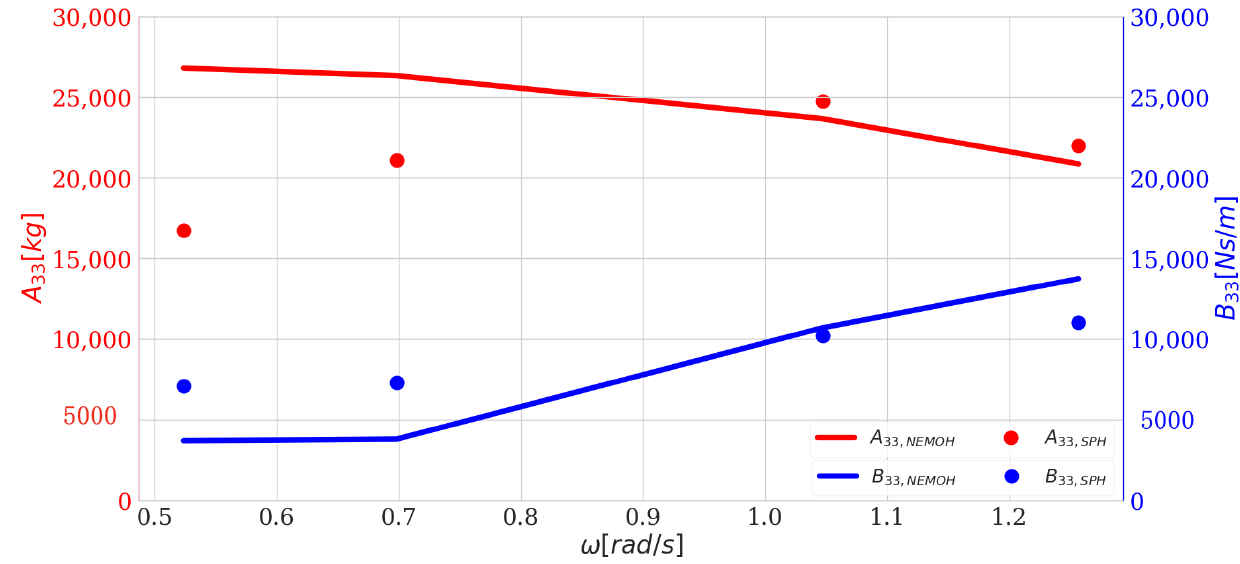
Figure 6. Hydrodynamic coefficients A 33 and B 33 calculated with NEMOH and with Smoothed Particle Hydrodynamics (SPH)–DualSPHysics for a sphere with a diameter of 5